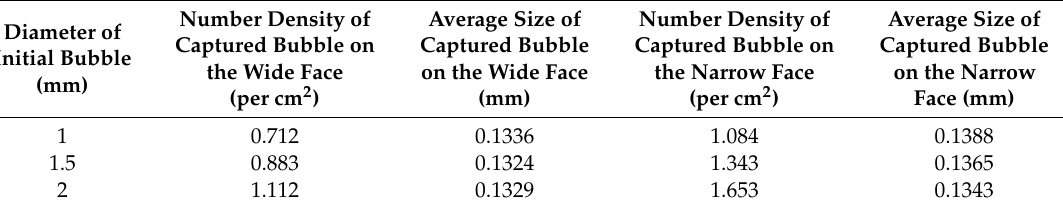
Table 7. Captured bubble distribution with di ff erent initial bubble sizes at the operation casting speed of 1.7 m / min and a gas flow rate of 4.1% gas volume fraction.